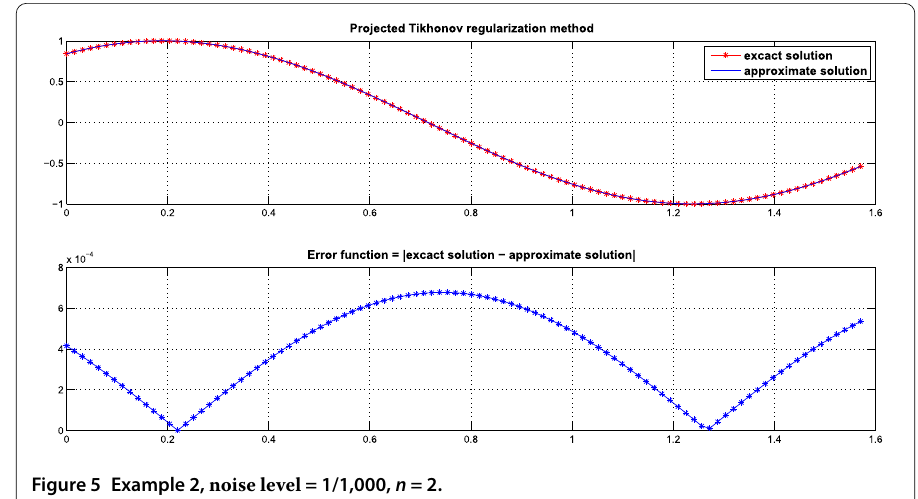
Figure 5 Example 2, noise level = 1/1,000, n = 2.